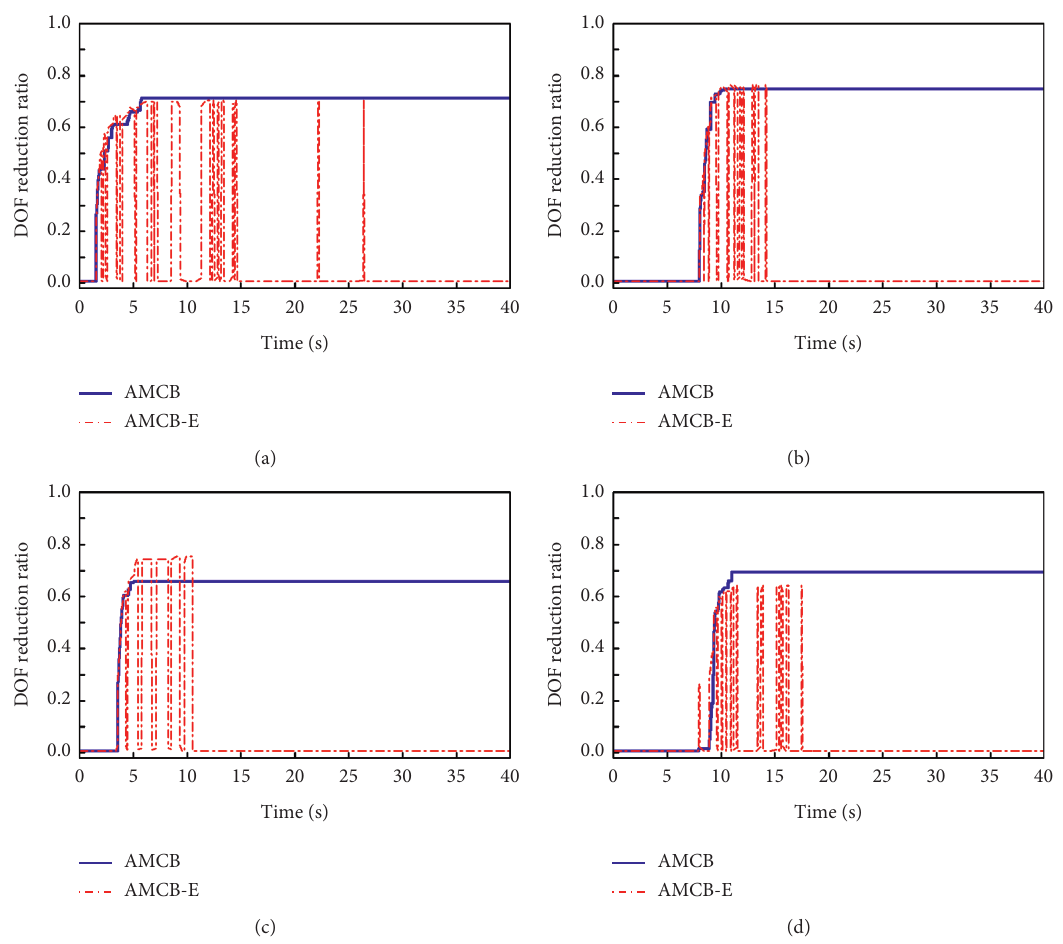
Figure 11: Time histories of DOF reduction ratio. (a) El Centro. (b) Kobe. (c) Northridge. (d)